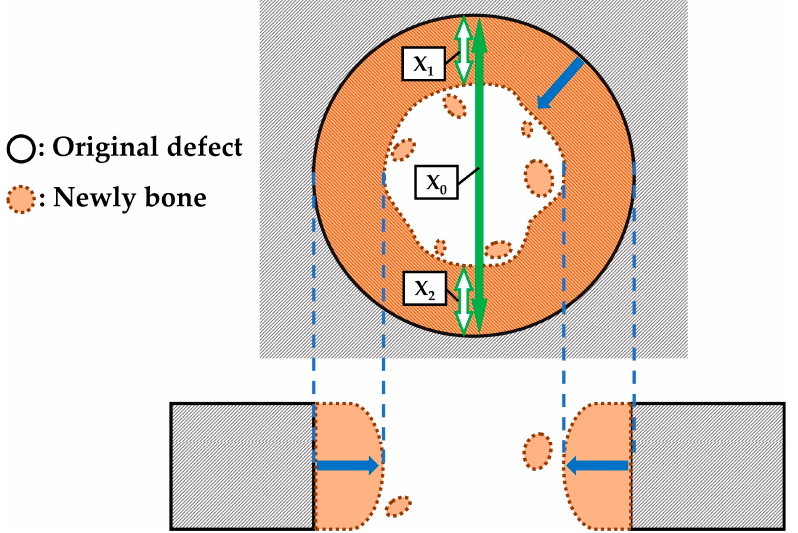
Figure 16. Illustration of top and cross-sectional views of the bone formation process at the rat cranial bone defects filled by cHLA/cAG/nHAp/BMP constructs. Note: Newly bone is depicted by zones in orange color. The edge of extending bone was shown by broken lines. The bone extension direction was indicated by the blue arrow. Bone extension rate was calculated by (X 1 + X 2 )/X 0 × 100 (%).